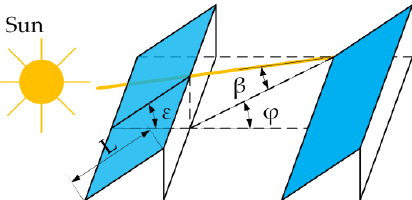
Figure 2. Schematic diagram of PV modules installated on a flat roof.